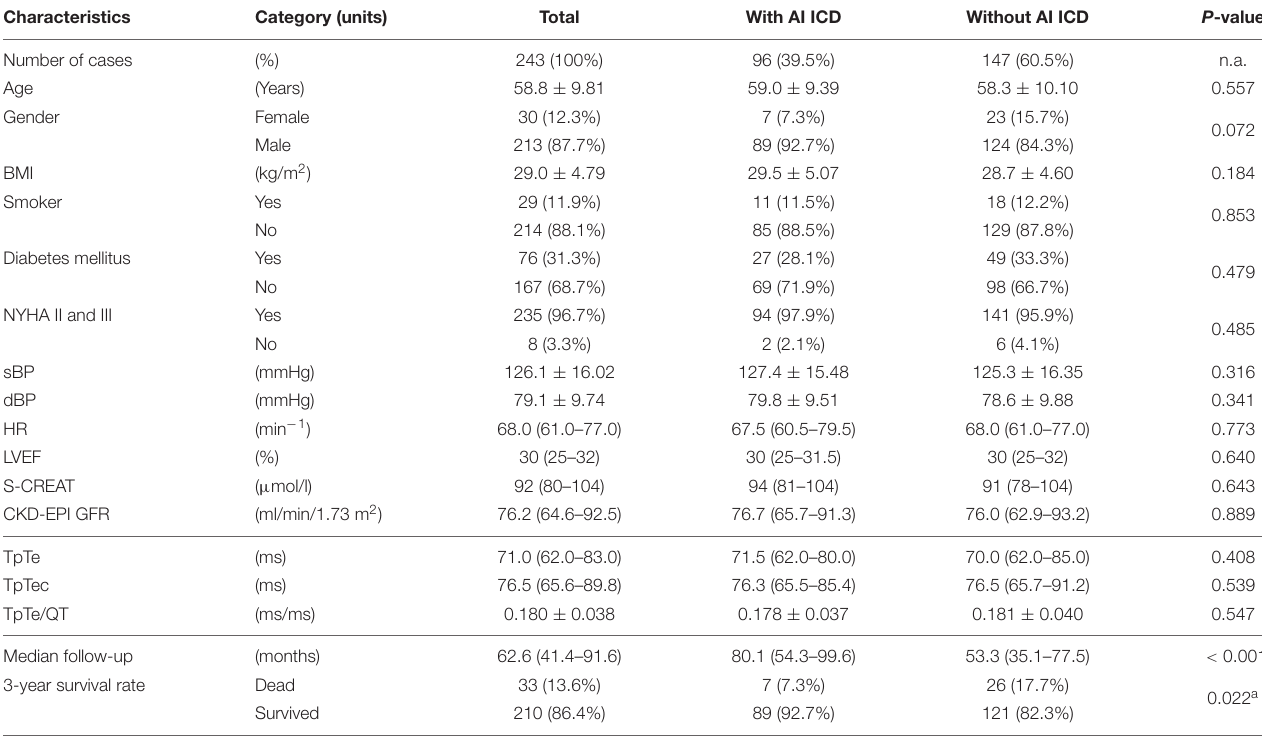
TABLE 1 | Clinical characteristics and follow-up data of patients grouped by the occurrence of appropriate ICD interventions. Characteristics